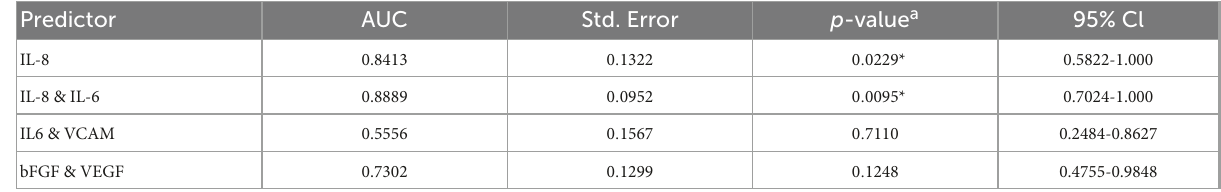
TABLE 5 Predictive accuracy of aqueous